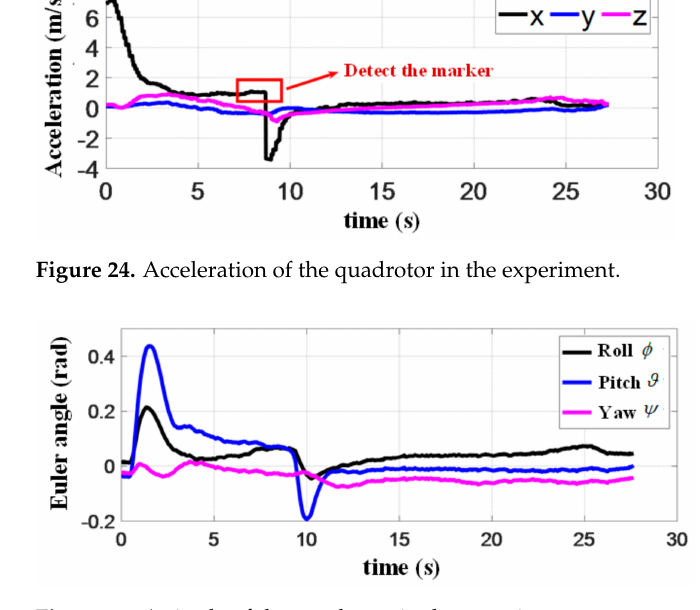
Figure 25. Attitude of the quadrotor in the experiment.